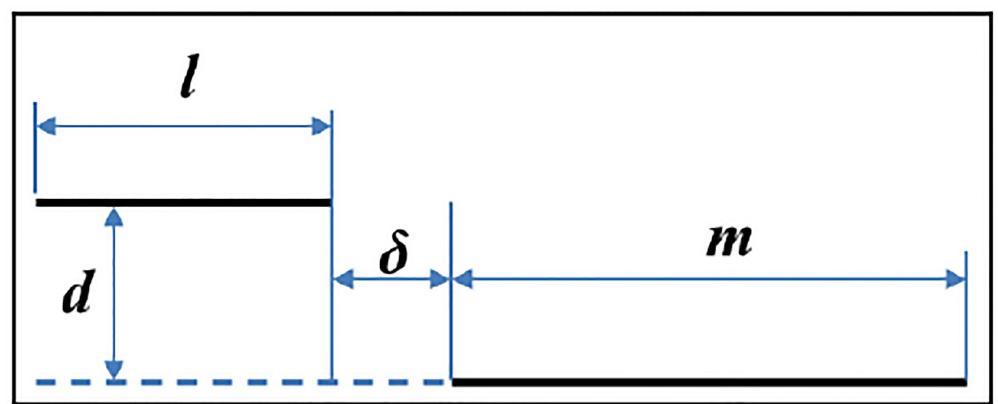
Fig 5. Scheme used to calculate the mutual inductance between two parallel conductors according to Grover’s equations.